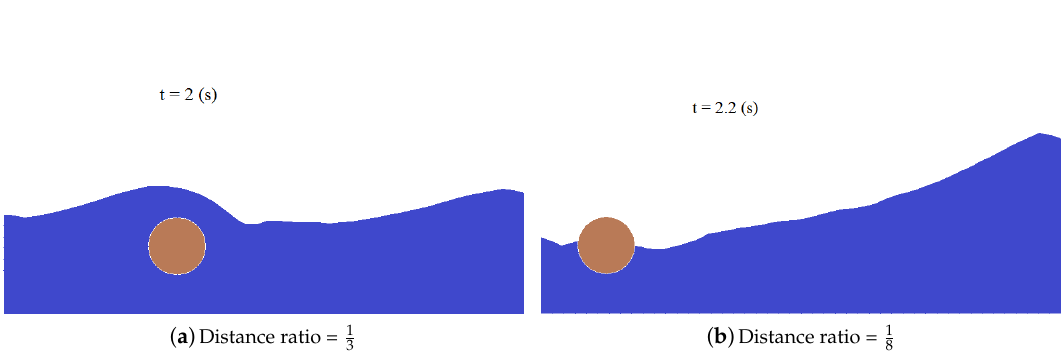
Figure 11. Free surface elevation of the fluid at various distance from the side